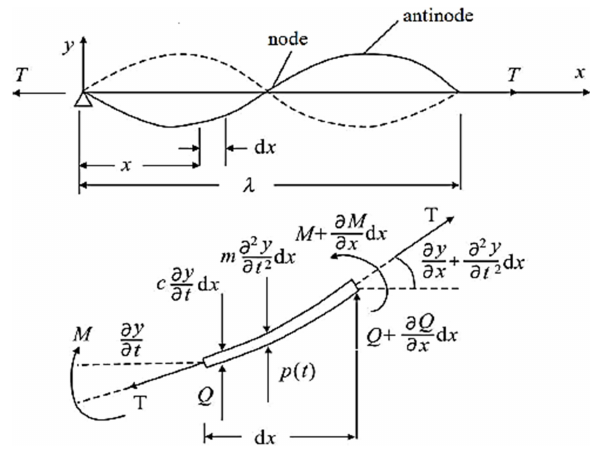
Figure 4: Stress investigation of vibration